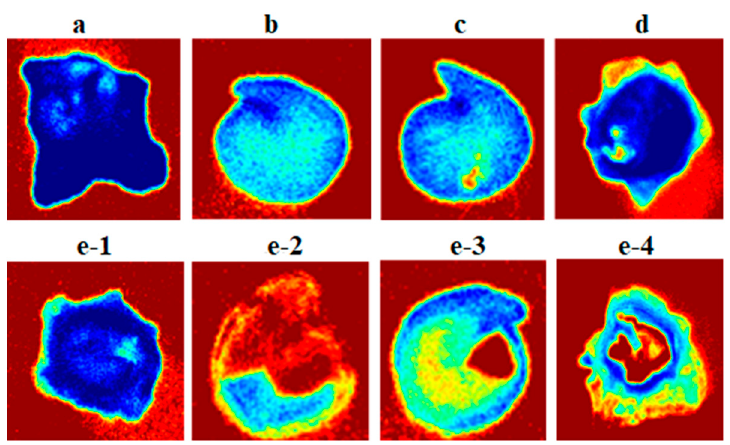
Figure 4. The nCDA-transformed images of mechanical damage class (1–5) in sugar beet seeds.